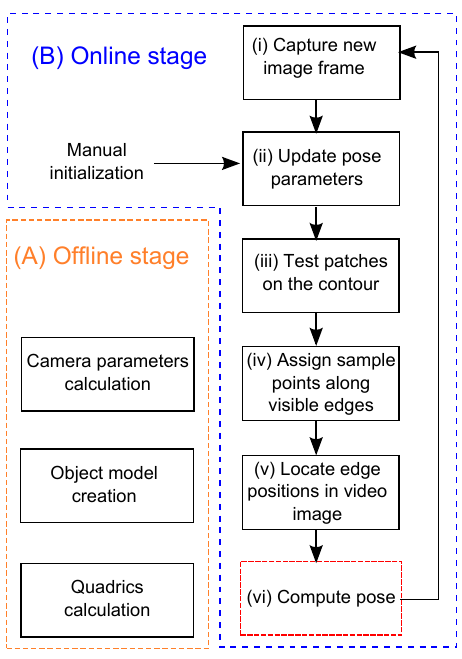
Fig. 3. An overview of our tracking framework: in (A), the offline stage with the camera parameters calculation, model creation and quadrics calculation and in (B) the online stage, with the optimization loop highlighted in red.